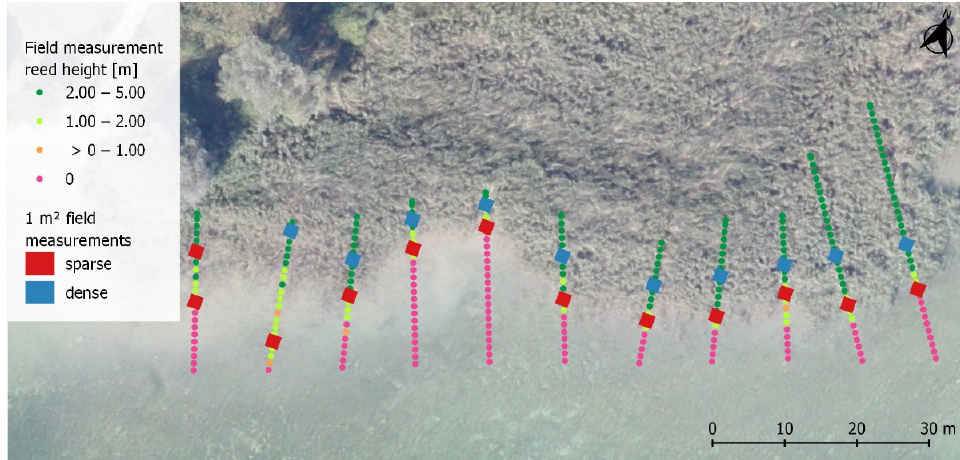
Figure 2. Schematic of the field survey, determining reed stem heights at every meter in each transect at AOI-06 on top of 3K-Orthomosaic.